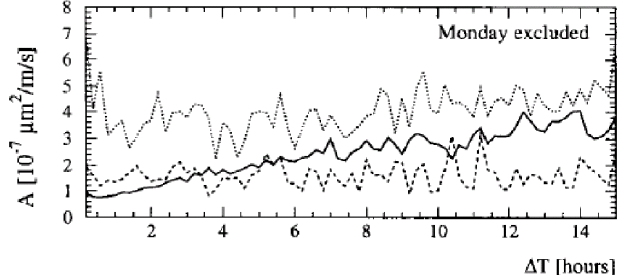
FIG. 26. Calculated diffusion constant A as a function of the time interval (cid:2) T in the ATL rule. The three different curves refer to the horizontal (solid) and vertical (dotted) data of Sec. I and the horizontal data of Sec. II (dashed line). The A constant was determined over a distance of about twice 15 m (from Ref.